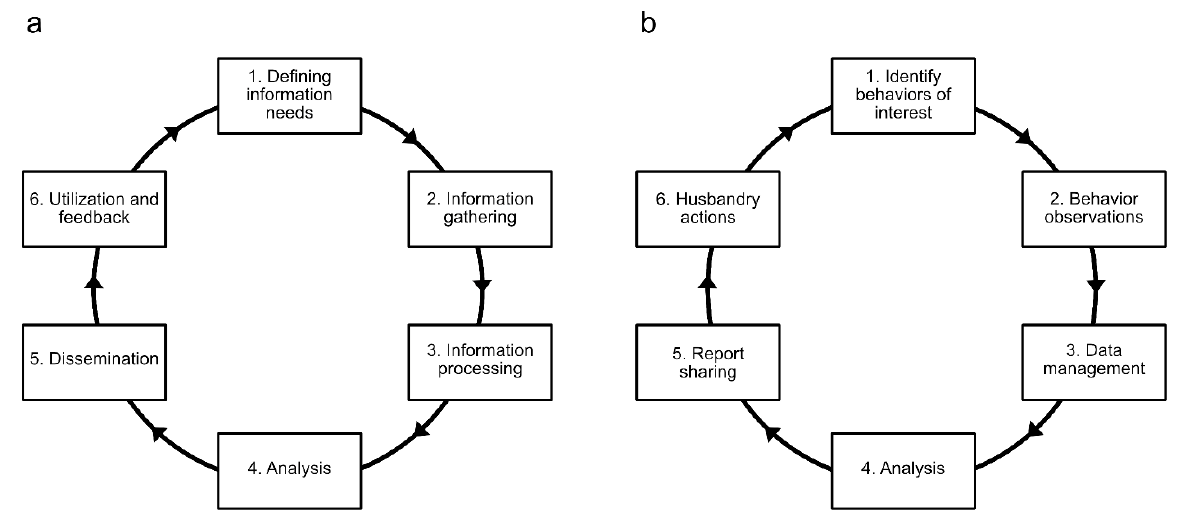
Figure 1. A diagram of the steps involved in ( a ) the business intelligence process as described by Vuori [21], and ( b ) a behavior monitoring